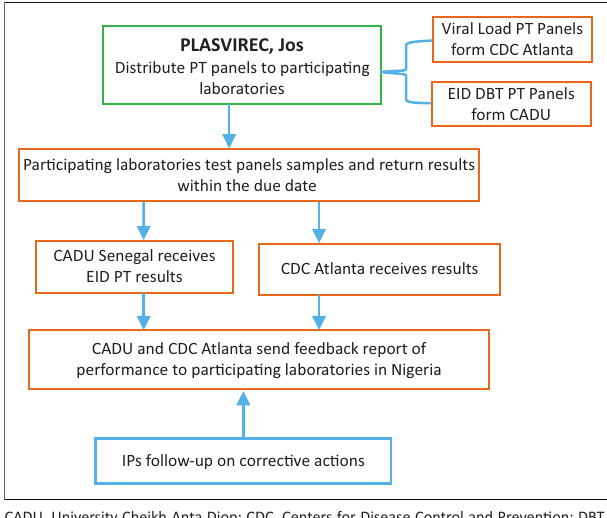
FIGURE 4: Early infant diagnosis and viral load external quality assessment